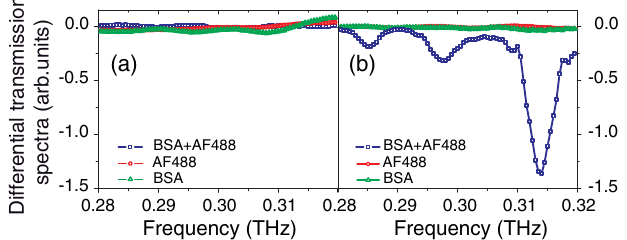
FIG. 6. Differential transmission spectra of the microwire- based absorption spectra. (a) Without blue light illumination (laser OFF), obtained with solvated AF488 in water (red circles), solvated nonlabeled BSA in water (green triangles), and BSA labeled with AF488 solvated in water (blue squares). (b) With blue light illumination (laser ON), obtained with solvated AF488 in water, at a concentration of 5 mg = mL (red circles); solvated nonlabeled BSA in water (green triangles); and BSA labeled with AF488 solvated in water (blue squares). Labeled and nonlabeled BSA concentrations are kept equal to 1 mg =